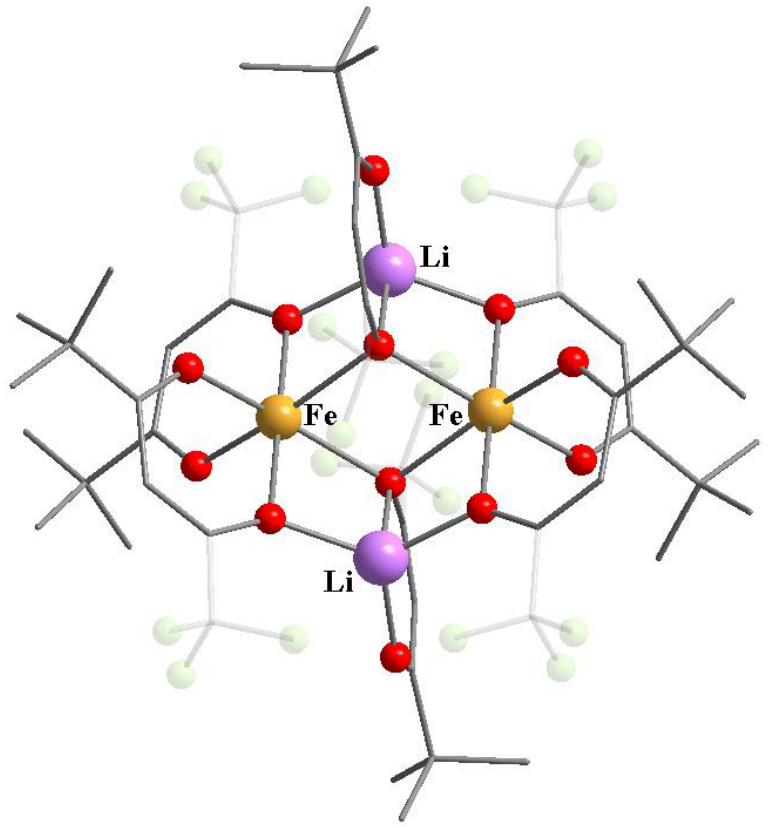
Figure 4. Molecular structure of 12 : (dik = ptac) [66]. Hydrogen atoms have been omitted, CF 3 groups of ptac are transparent for clarity. The cif has been retrieved from CCDC. CCDC number is 1518385.